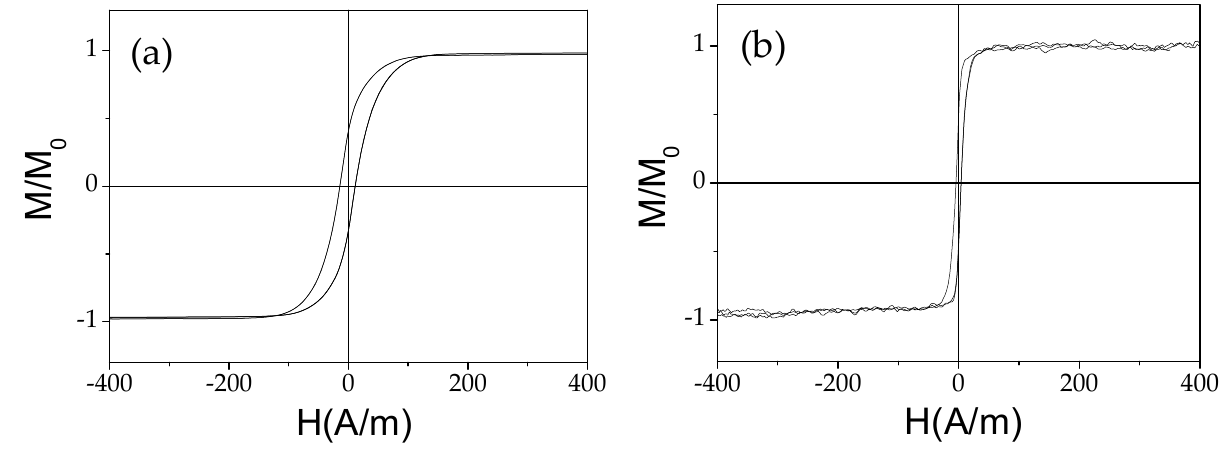
Figure 1. Hysteresis loops of as-prepared Co 64.04 Fe 5.71 B 15.88 Si 10.94 Cr 3.4 Ni 0.03 ( a ) and Co 66 Cr 3.5 Fe 3.5 B 16 Si 11 ( b ) microwires.